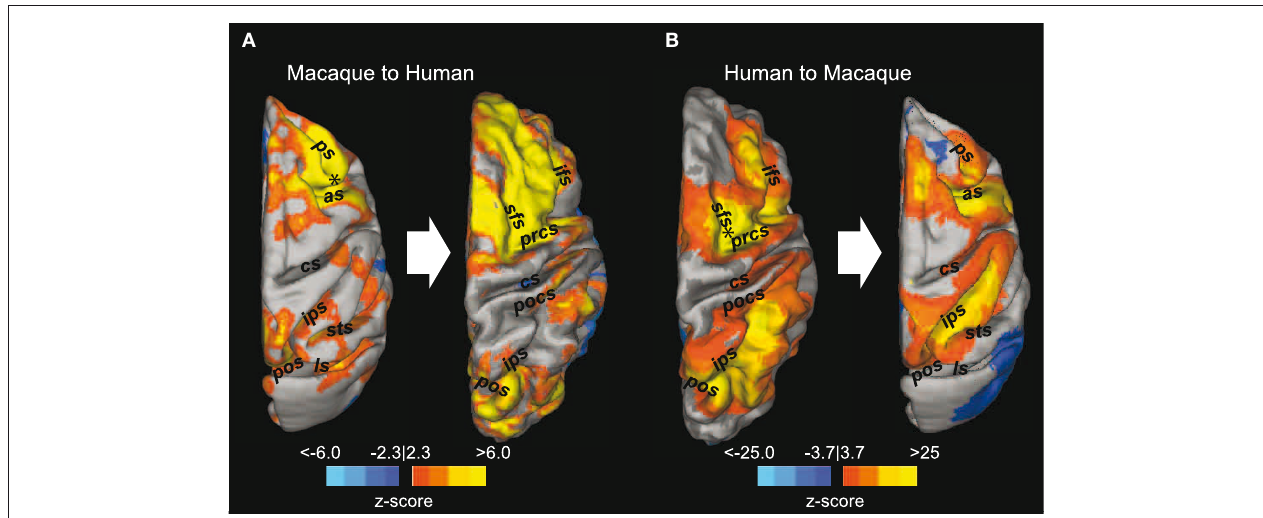
species using cortical surface-based transformation ( A,B right side). as, arcuate sulcus; cs, central sulcus; ifs, inferior frontal sulcus; ls, lateral sulcus; pos, parieto-occipital sulcus; pocs, posterior central sulcus; prcs, precentral sulcus; ps, principal sulcus; sfs, superior frontal sulcus; sts, superior temporal sulcus. Reprinted with permission from Hutchison et al.